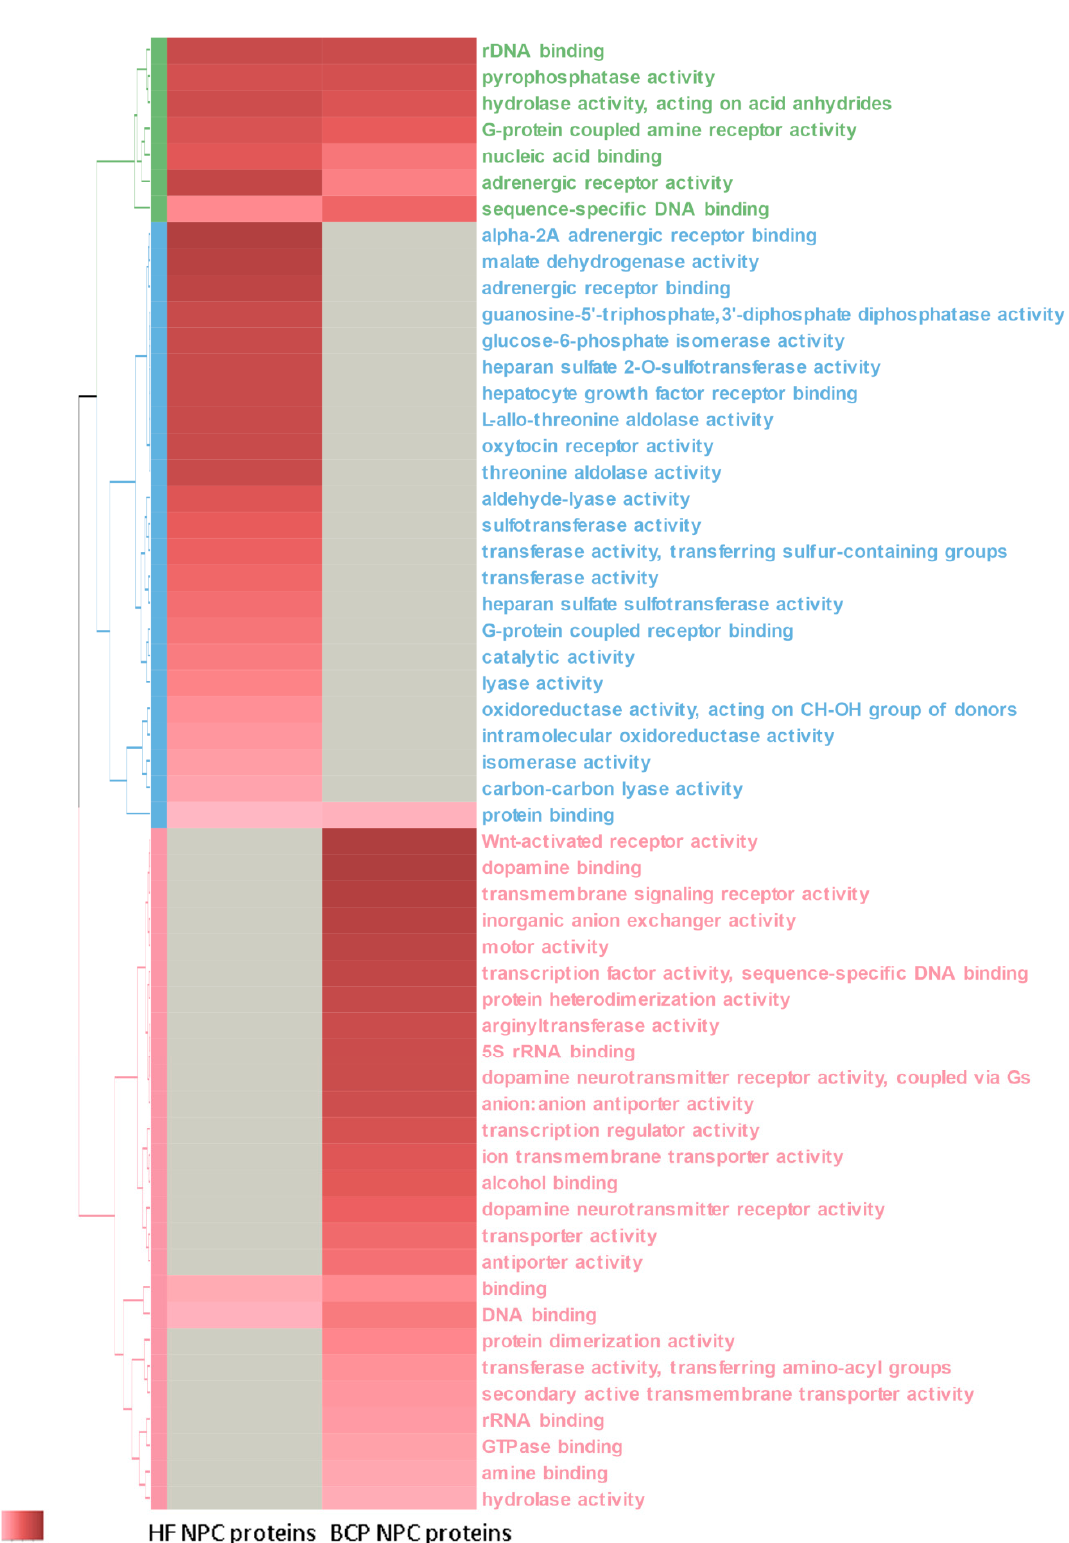
Figure 6. Heat map and dendrogram of the results of GO functional enrichment analysis of NPC proteins from BCPs and HFs by molecular functions obtained via STRING (https://string-db.org/, accessed on 1 March 2023) and visualized using R (https://www.r-project.org/, accessed on 1 March 2023). GO results with p < 0.05 are shown as normalized − log ( p ) values.